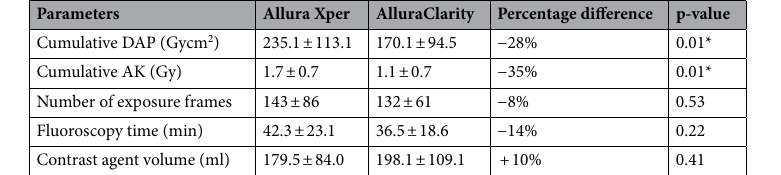
Table 3. Procedure parameters during AVS. Data presented as mean ± standard deviation, * =